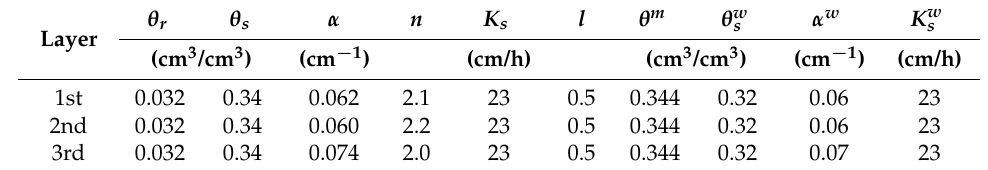
Table 2. Hydraulic parameters obtained by the model after calibration.